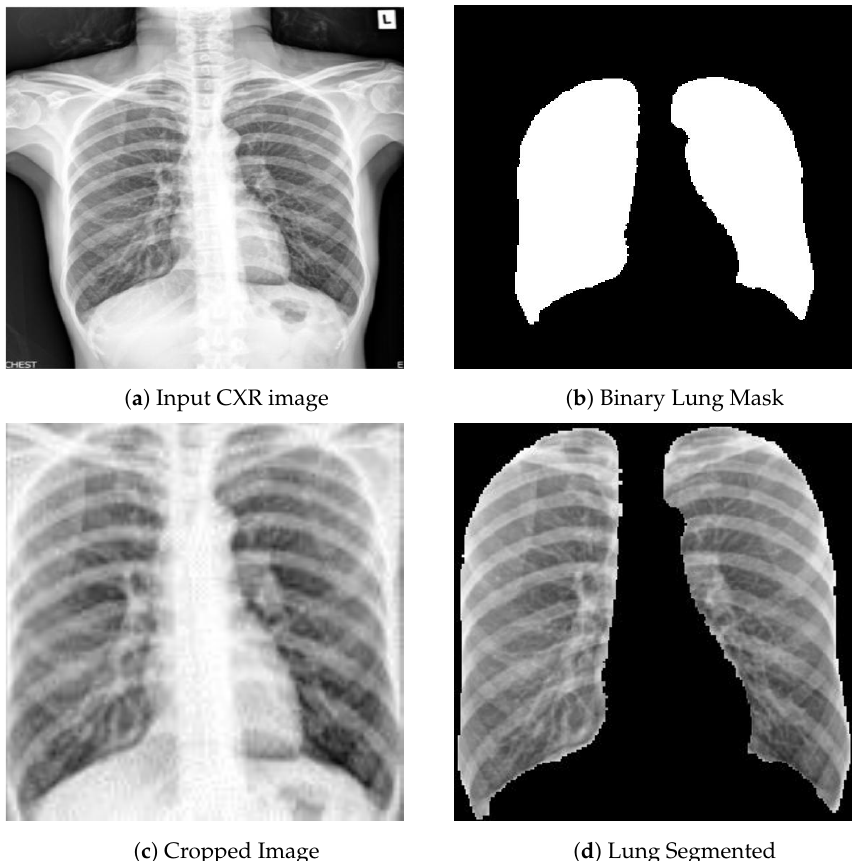
Figure 3. Original CXR ( a ) is fed to the U-Net, which outputs a binary lung mask ( b ) with which the original CXR is cropped( c ) and the lungs are segmented ( d ) in the cropped bounding box.